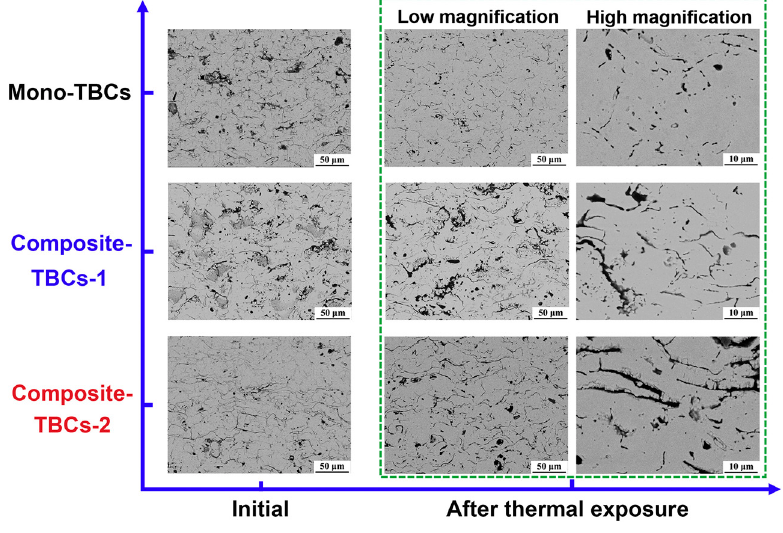
Figure 47. Structural evolution of the three kinds of TBCs during thermal exposure [234] .